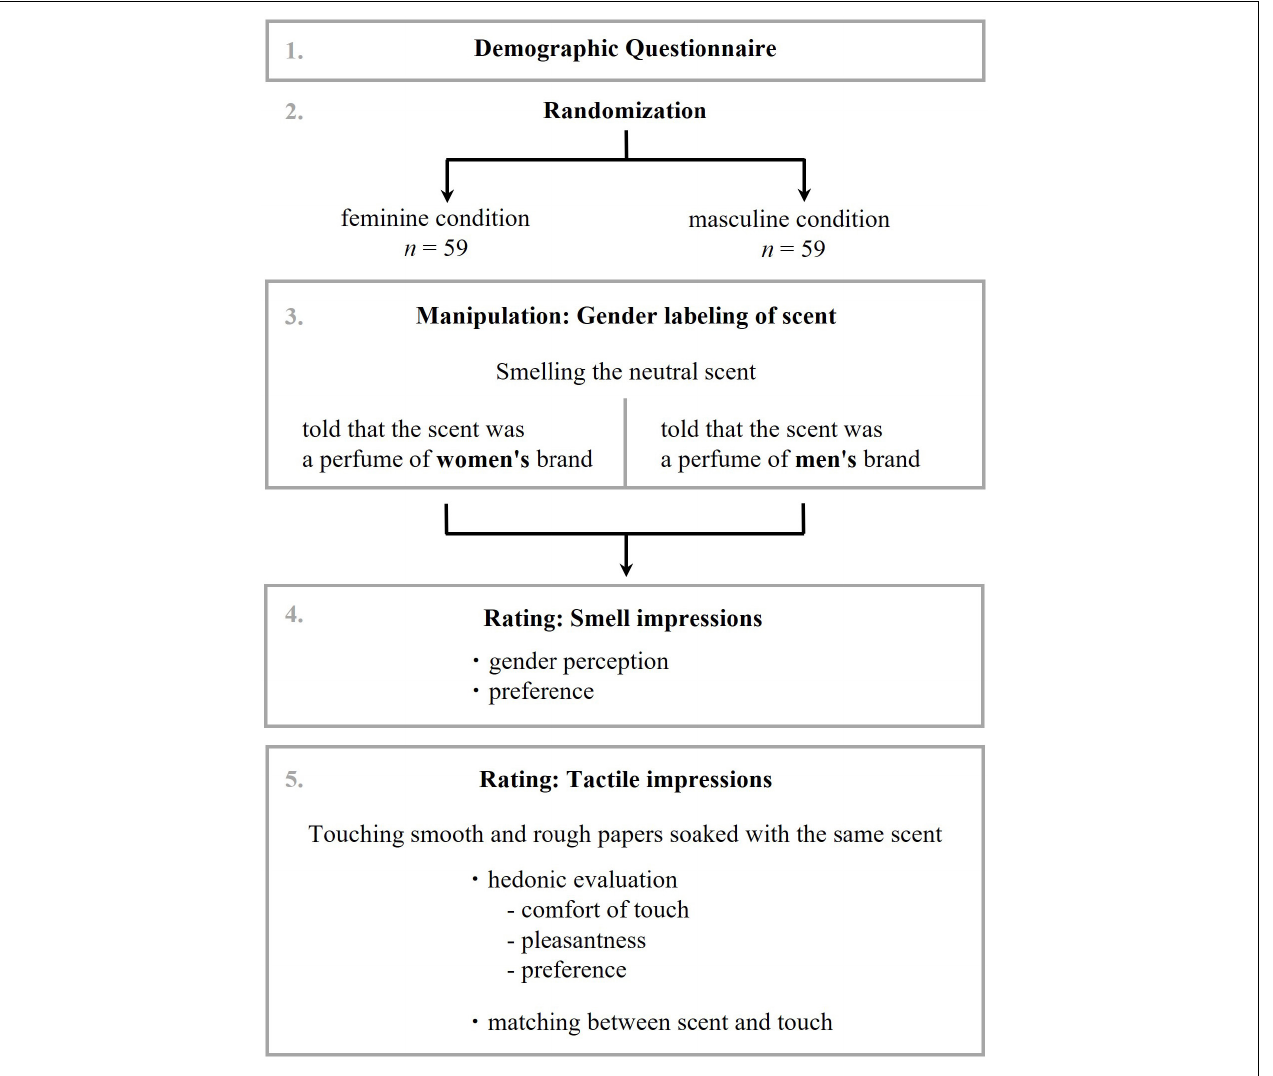
FIGURE 2 | Flow chart of experimental